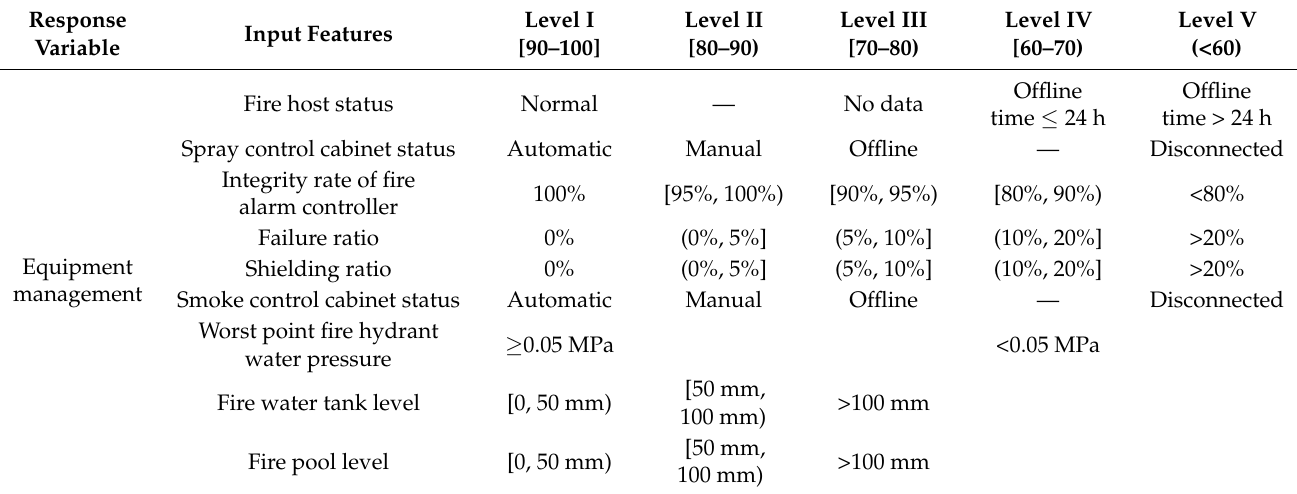
Table 1. Examples of fire risk indicators for equipment management.